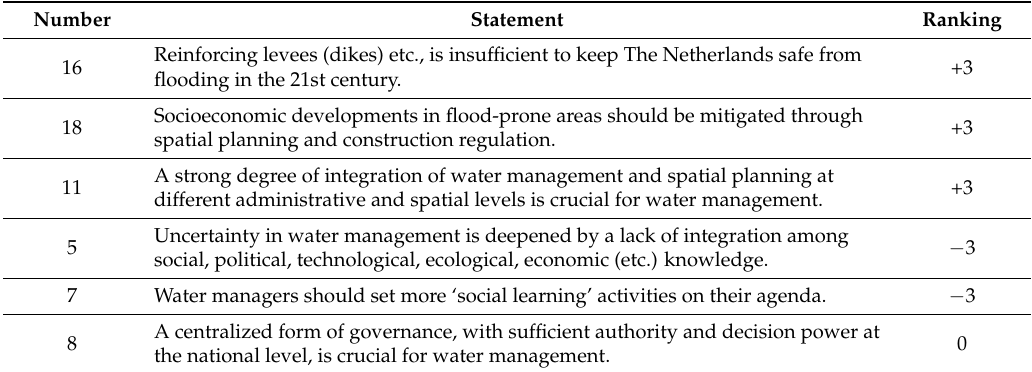
Table 1. Distinguished statements about IWRM in frame